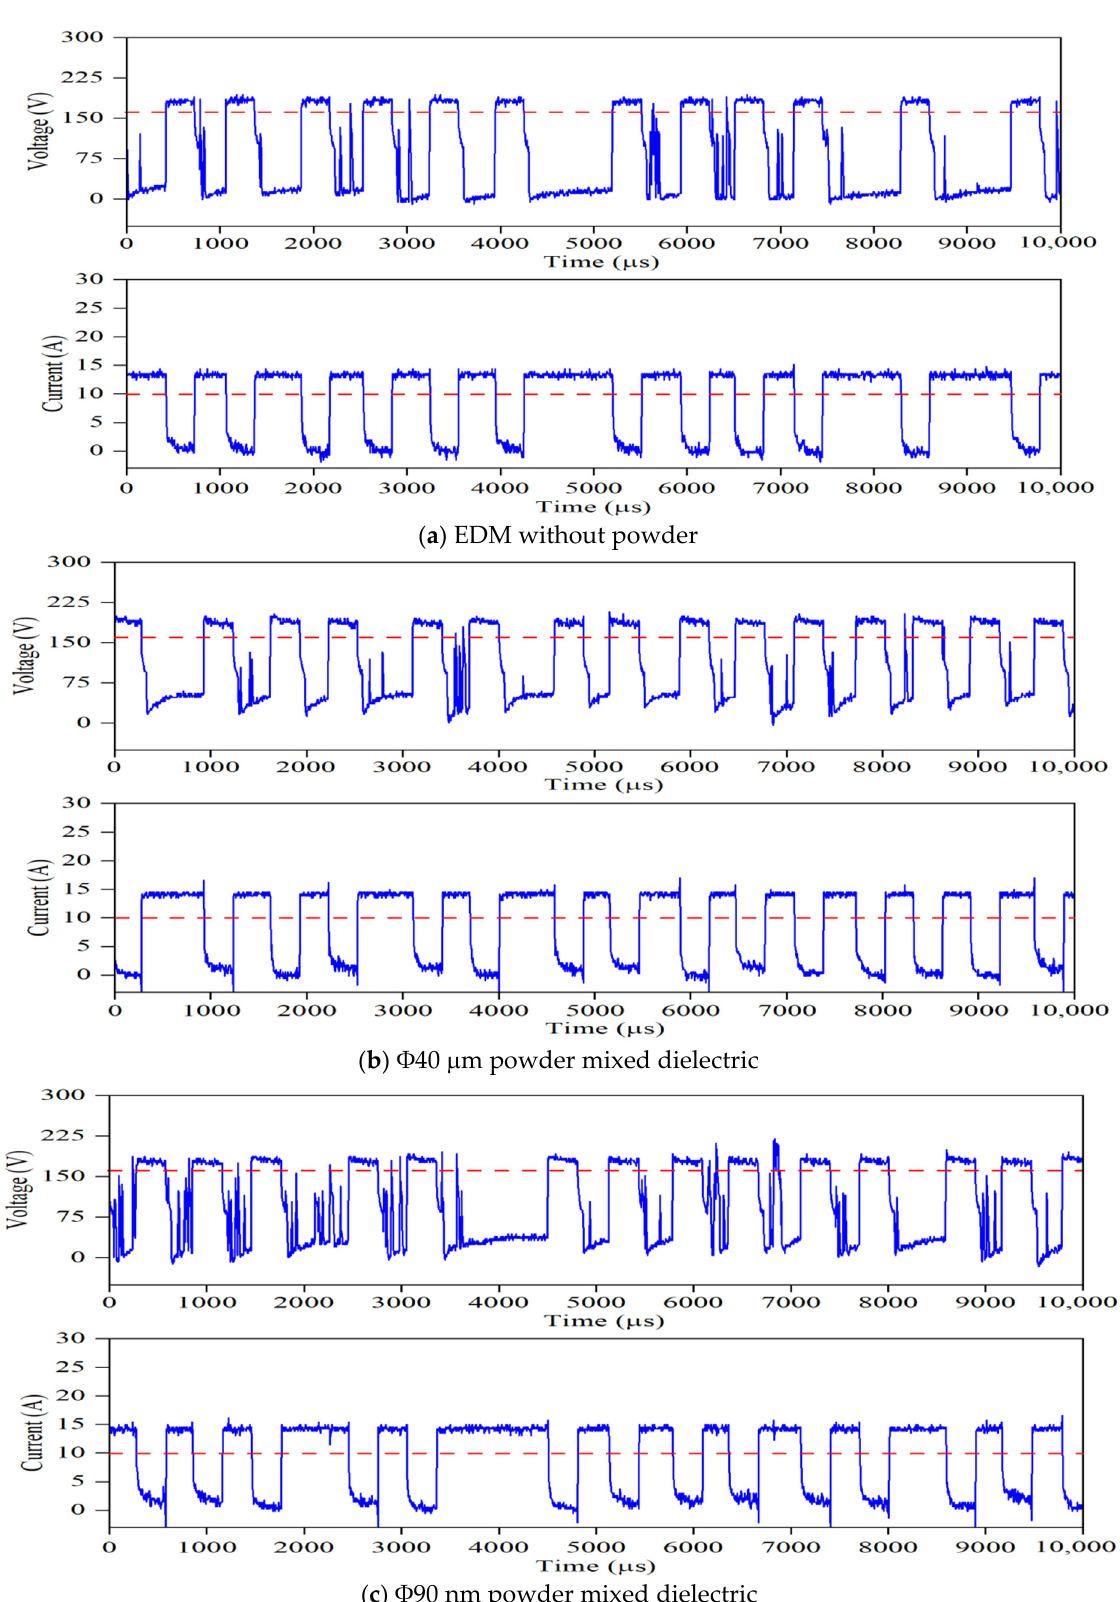
Figure 4. Typical voltage and current pulse train acquired for discharge duration 300 µ s, peak current 6A and gap voltage 80 V (--- Threshold value).